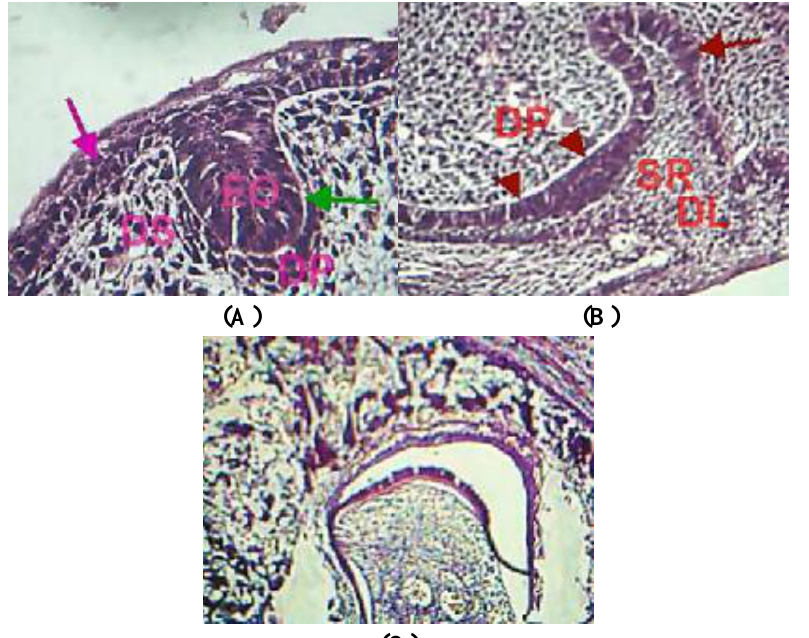
Figure 1: control group (H&E stain). (A) View of upper jaw of rat 16 th day I.U.L,tooth germ at bud stage, Oral ectoderm(pink arrow),Basement membrane(green arrow),Enamel organ(EO),Dental papilla(DP),Dental sac(DS) (X20). (B) at 18th day IUL, tooth germ shows Outer enamel epithelium.(arrow),Inner enamel epithelium.(arrow heads),Dental papilla(DP), Stellate reticulum(SR),Dental lamina(DL) (X20).(C) One day postnatal, Tooth germ at bell stage (X10).